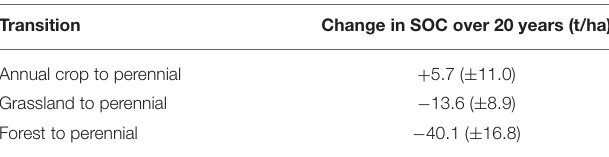
TABLE 2 | Soil Organic carbon transitions to 100cm below the surface over 20 years after transition. Transition Change in SOC over 20 years (t/ha) Annual crop to perennial + 5.7 ( ± 11.0) Grassland to perennial − 13.6 ( ± 8.9) Forest to perennial − 40.1 ( ± 16.8) Reproduced from Table 1 of Ledo et al.